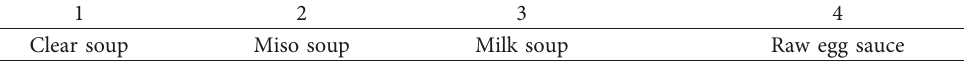
Table 1: Meal menus for each